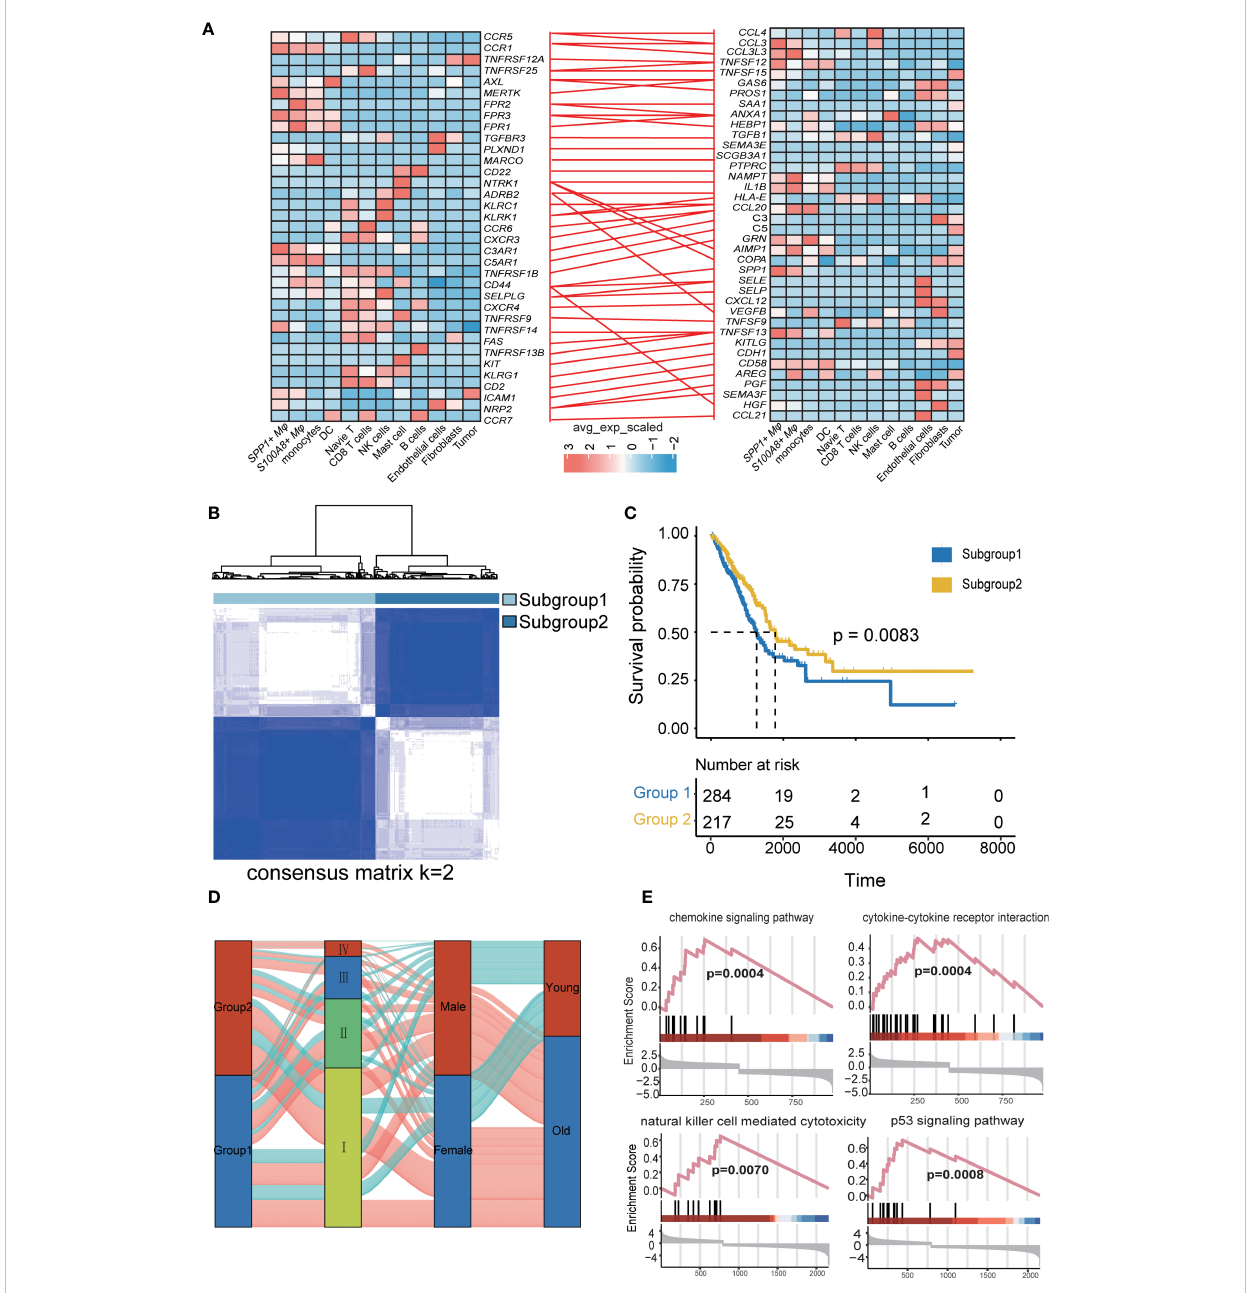
FIGURE 5 Identi fi cation and validation of the LRI-based classi fi cation of LUAD patients. (A) The ligand − receptor interaction pairs. The color of the line between the ligand receptors represents differential LRIs between untreated patients and different treatment responses. (B) Consensus clustering matrix for the ideal cluster size in the TCGA LUAD cohort, k = 2, which was represented by the matrix. (C) Kaplan − Meier survival analyses of the patients in subgroups 1 and 2 of LUAD in the TCGA showed that subgroup 1 patients had a worse OS than subgroup 2 in the LUAD patients. (D) Alluvial diagram depicting the relationships between LRIs and clinicopathological characteristics in two subgroups of LUAD patients in the TCGA cohorts. (E) GSEA of the chemokine signaling pathway, cytokine − cytokine receptor interaction pathway, natural killer cell-mediated cytotoxicity pathway, and p53 signaling pathway between the two